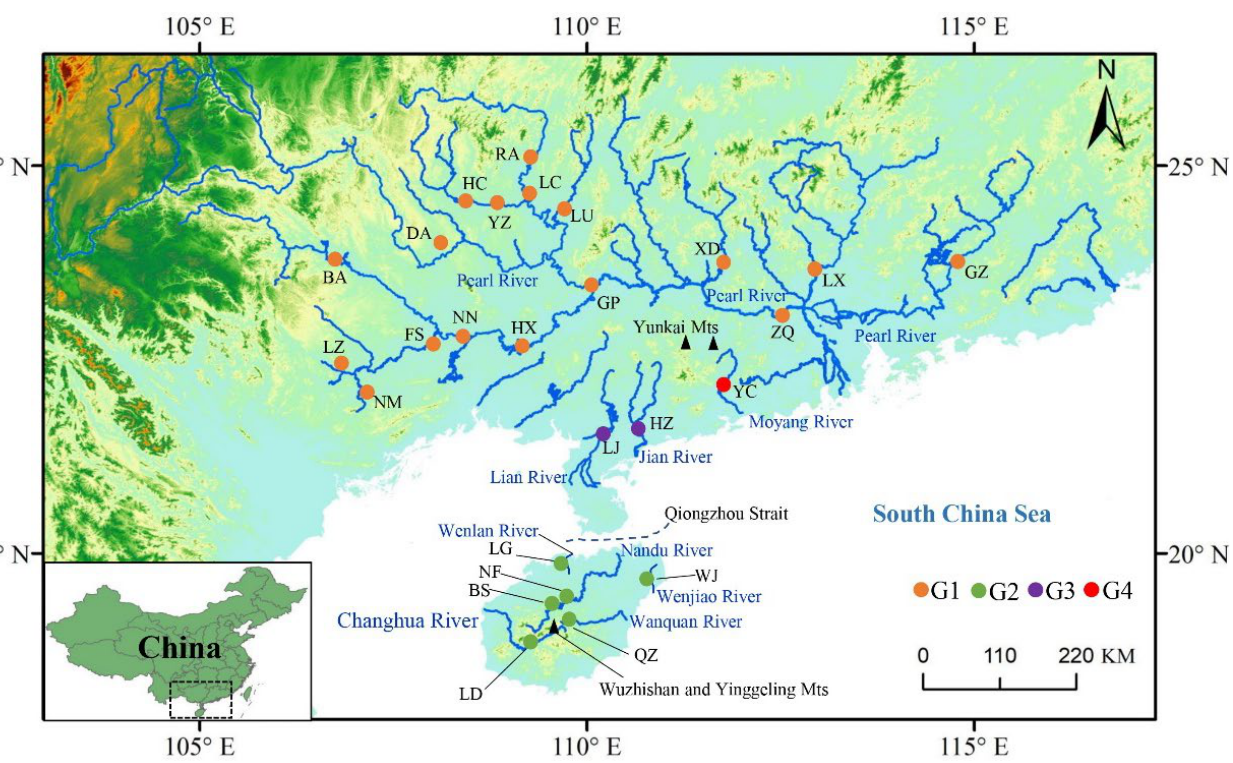
Figure 1. Toxabramis houdemeri sampling sites in the current study. The pie charts represent the four mitochondrial groups defined based on the mitochondrial network. Population codes are defined in Table 1.